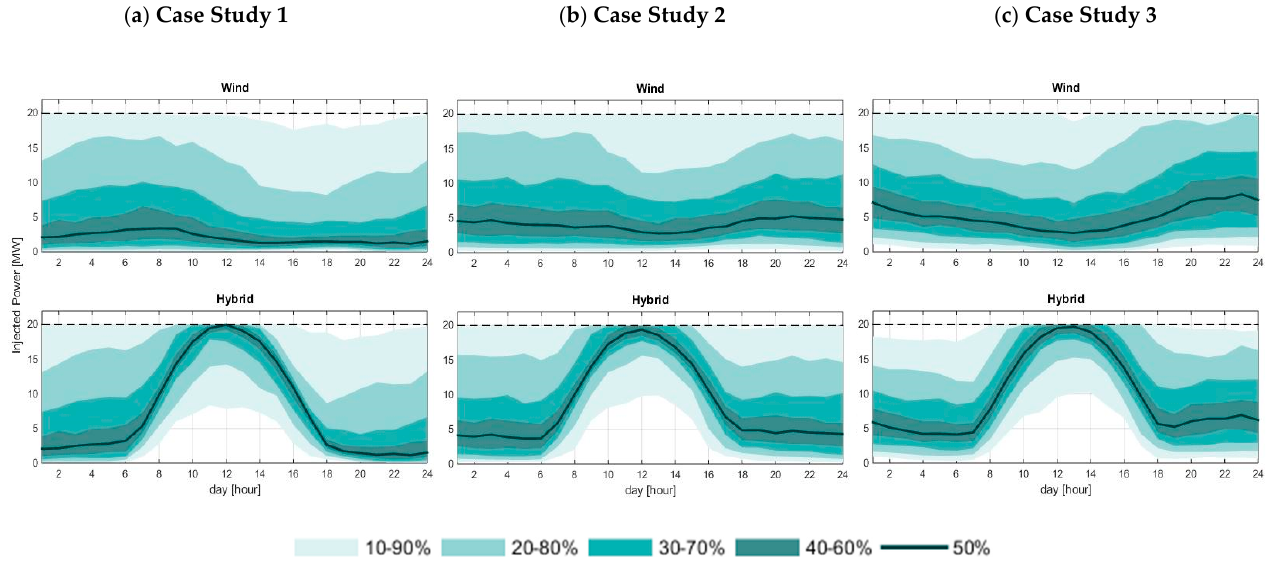
Figure 6. Percentiles 10 to 90 of the daily power injection profile for the wind and hybrid scenarios in the case studies analyzed.